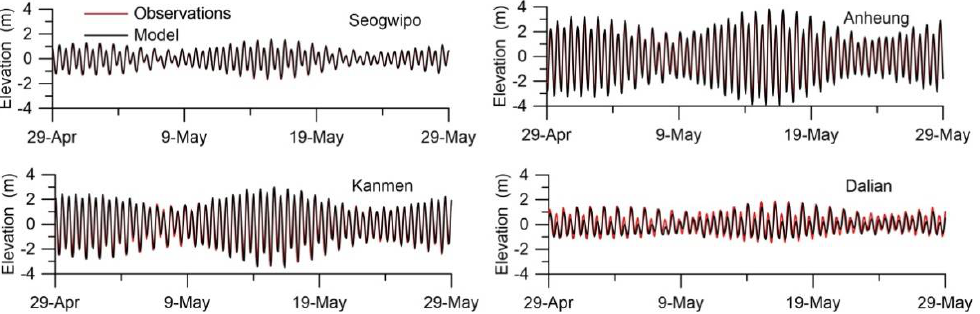
Figure 6. The comparison of the time series of observed tide elevations (red lines) in May 2011 with model-computed elevations (black line) in four locations (Seogwipo, Anheung, Kanmen, Dalian), which are shown in Figure 3.